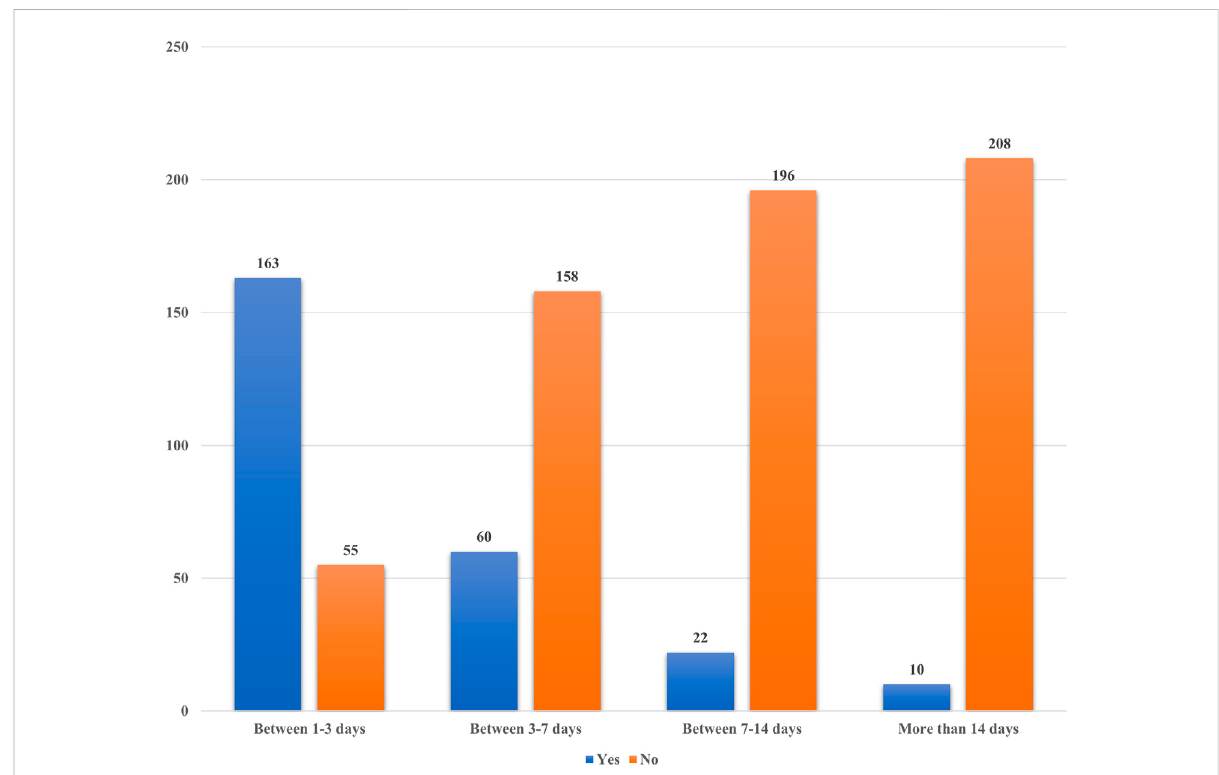
FIGURE 8 Duration of young people ’ s stay in ecotourism destinations in Sibiu County in 2020 and